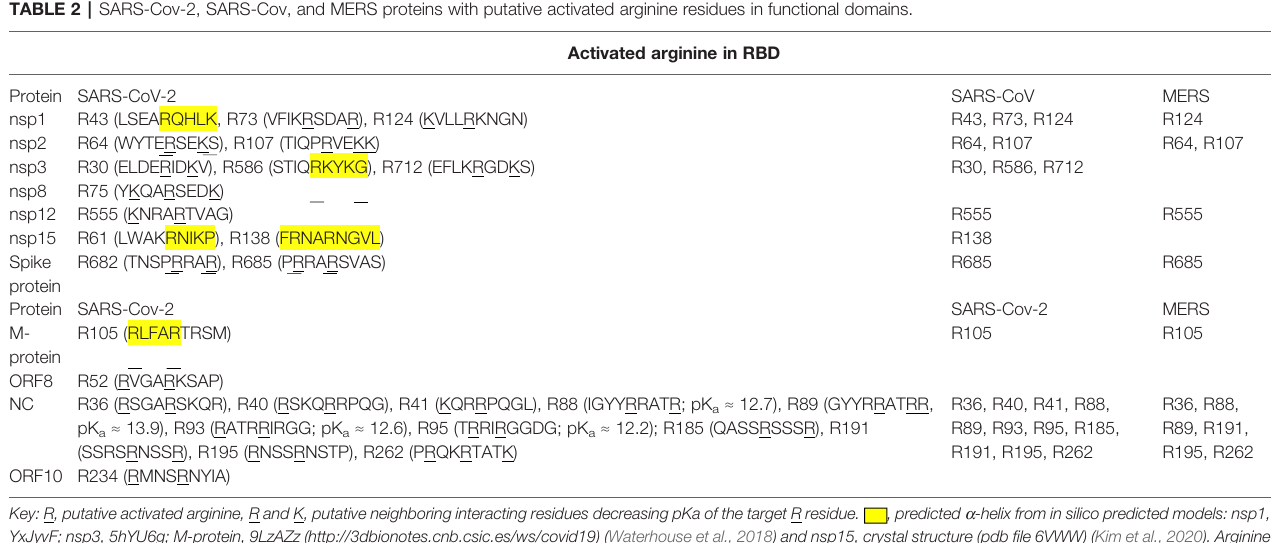
TABLE 2 | SARS-Cov-2, SARS-Cov, and MERS proteins with putative activated arginine residues in functional domains.